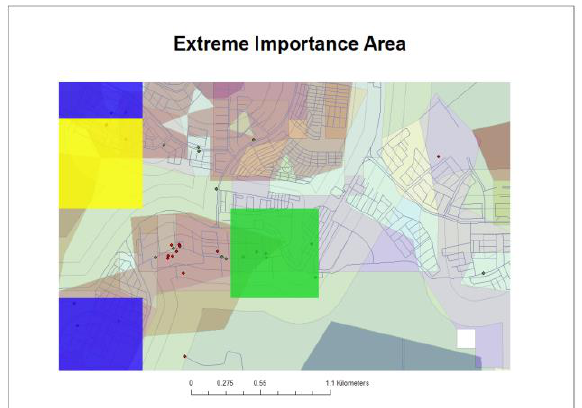
Figure 5 MCDA Result for Extreme Importance Area